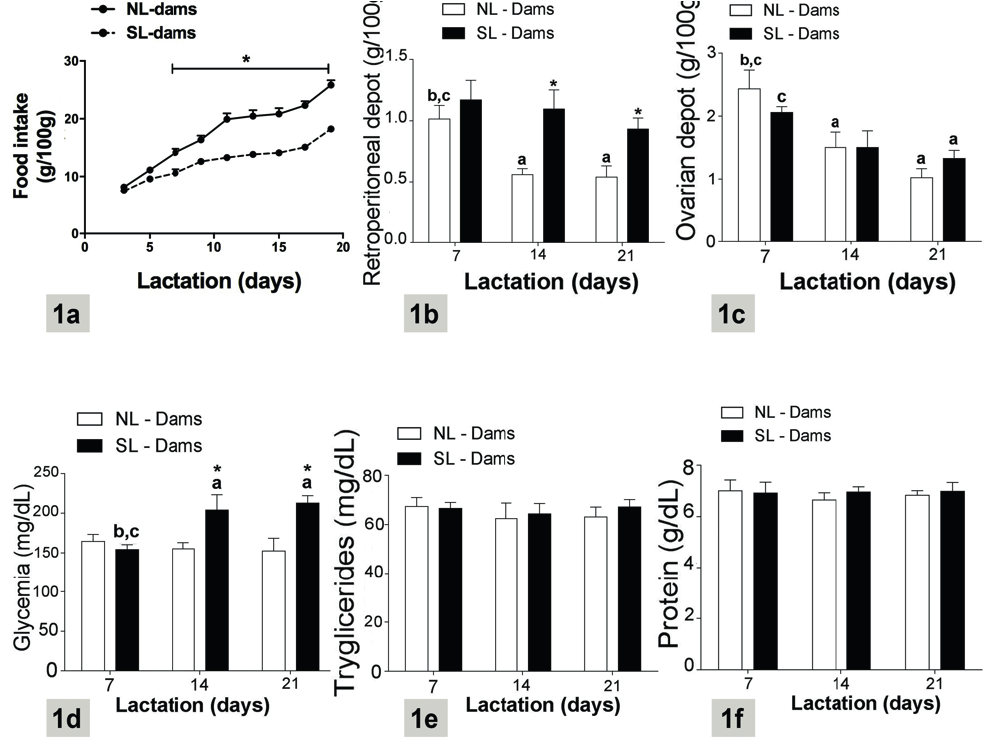
Figure 1 - Biometric, serum parameters and WAT content in lactating SL-dams and NL-dams during different lactational phases. The values are expressed as mean ± Standard Error of the Mean (n= 9-12 animals/group). The symbol above bars indicates a significant difference (p<0.05) between the groups (Two-way ANOVA with uncorrected Fisher´s LDS: * SL versus NL; a 7 th day of lactation; b 14 th day of lactation and c 21 st day of